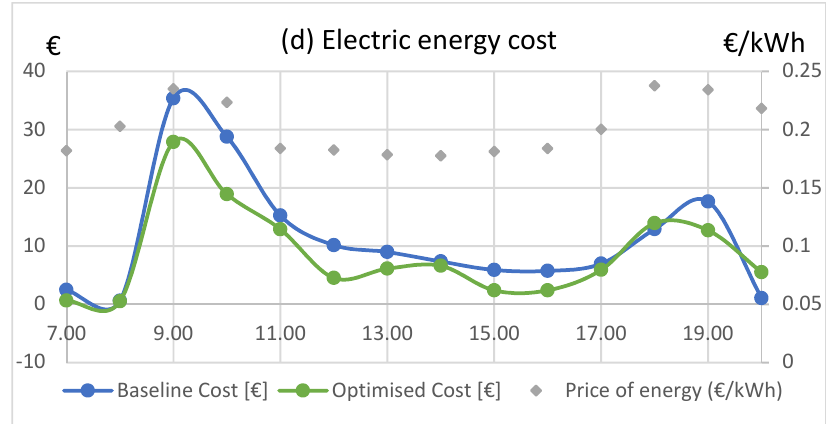
Figure 3. GA HVAC optimization results for 25 January 2018 (winter).